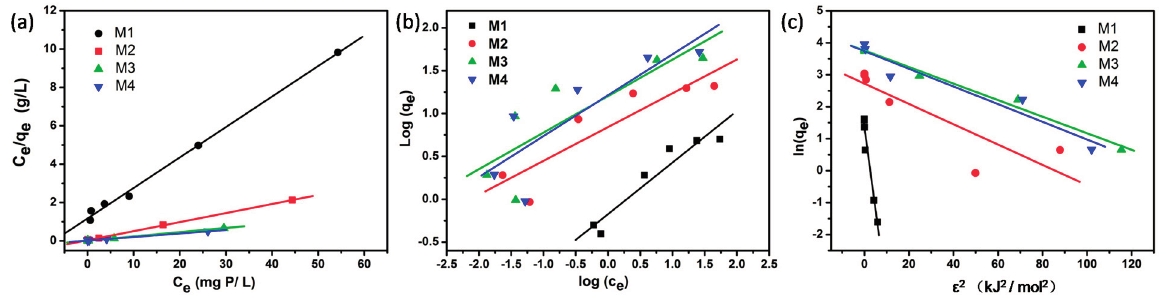
Figure 2. Linear fitting plots of ( a ) Langmuir, ( b ) Freundlich, and ( c ) Dubinin-Radushkevich isotherm models for the four adsorbents (M1, M2, M3 and